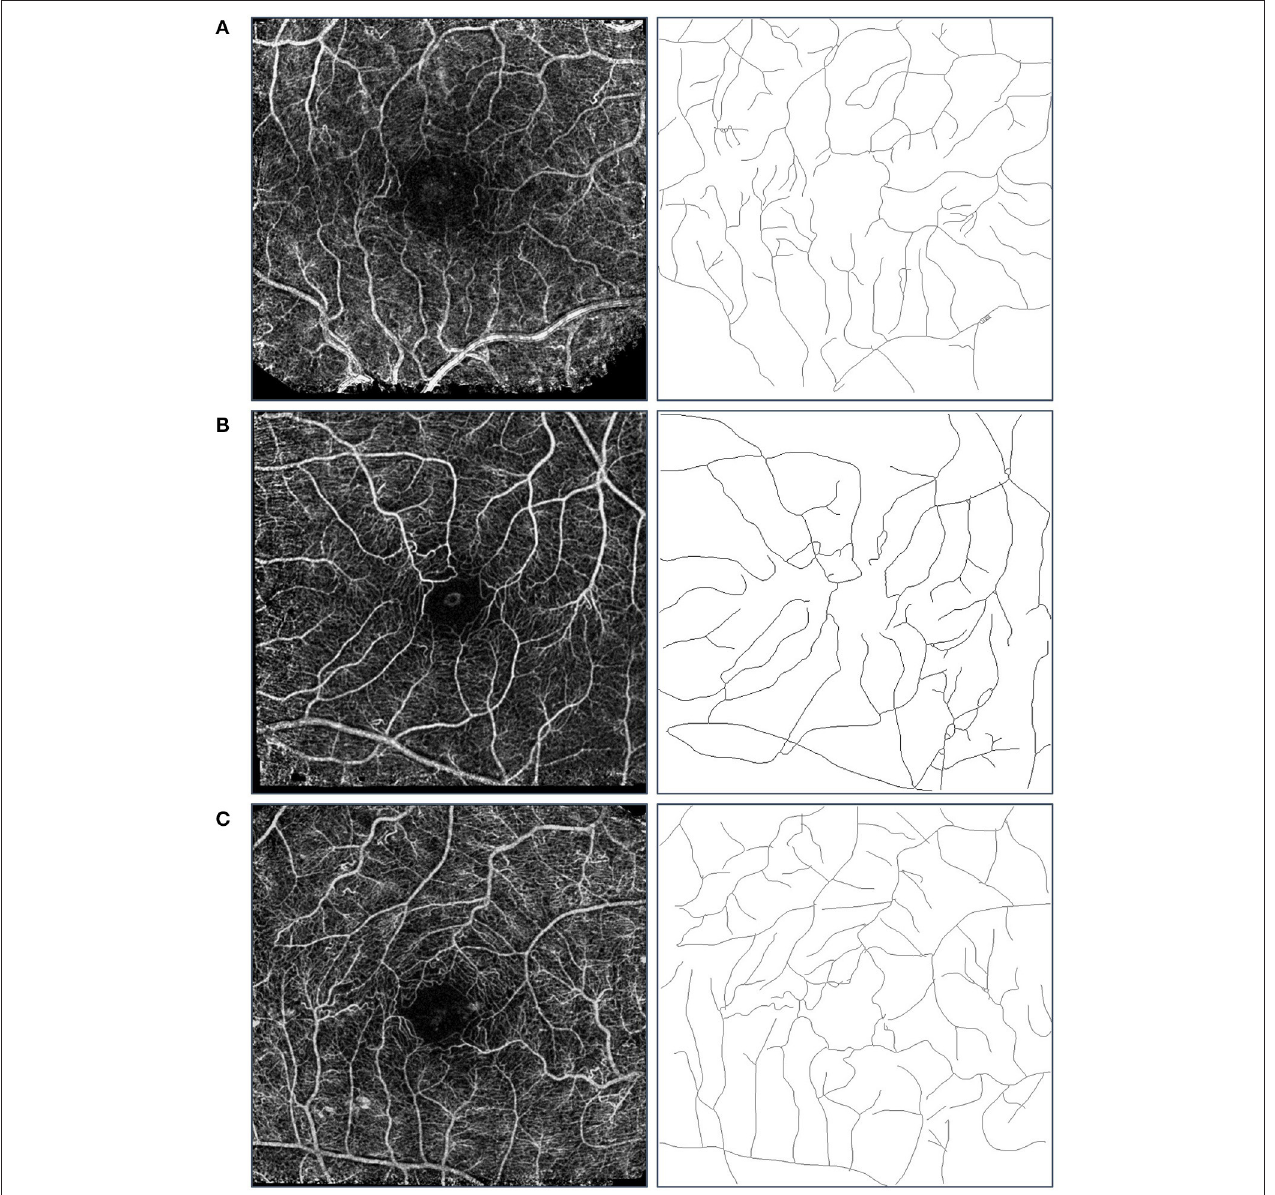
FIGURE 3 | Sample images used in the fractal analysis. Images in the left column are the composite nCPM images generated from the RFI system, while those in the right are their respective skeleton images that were used in the fractal analysis. Row (A) is from the healthy group, Row (B) from the DM group, and Row (C) from the MDR group. We note that the blood vessel types used in the analysis were the major arterial and venous